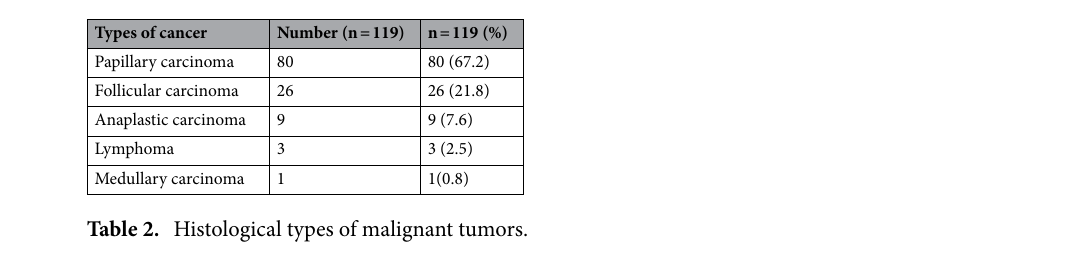
Table 1 represents the clinical and ultrasound characteristics for all 549 patients operated on for thyroid nodules, including 468 females (85.2%), and according to the nature of the mass. The average age of the participants was 45 ± 14 years and did not differ significantly between patients with malignant nodules and those with benign nodules. Of all patients, 21.7% had malignant nodules and 78.3% had only benign nodules. The frequency of thyroid cancer was 48.4% in patients younger than and at 20 years old, 31.1% in those aged 60 and over and 19.6% in those aged 40 to 59 years